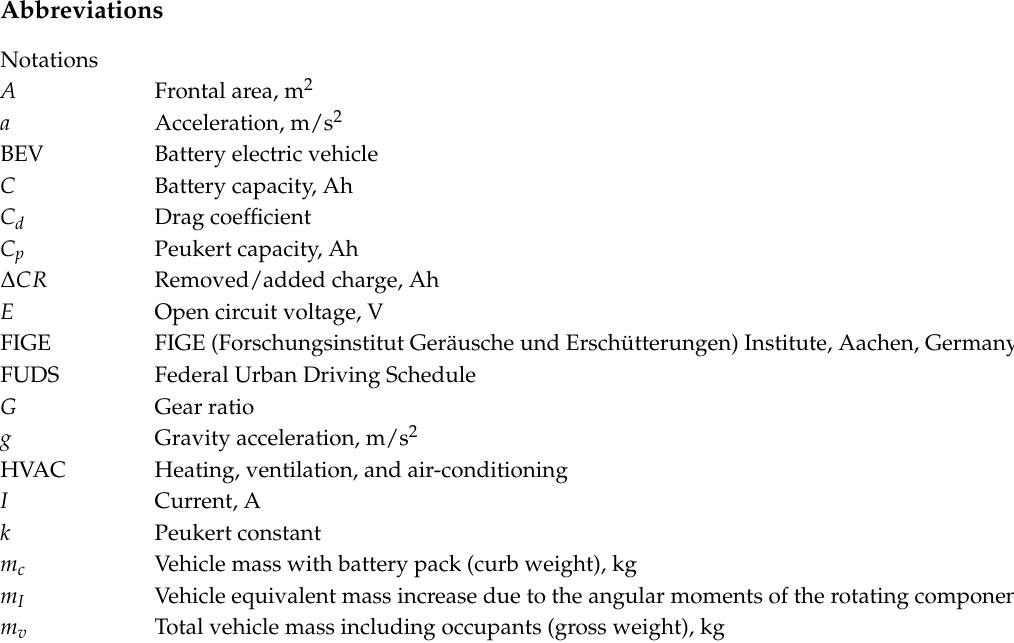
FIGE (Forschungsinstitut Geräusche und Erschütterungen) Institute, Aachen,